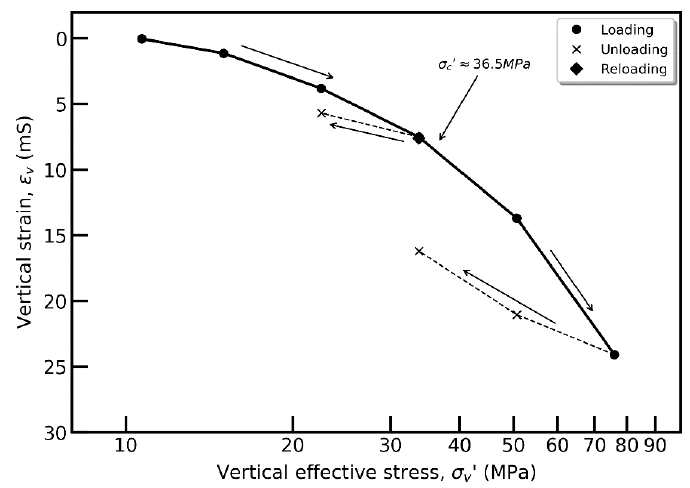
Figure 13. The vertical strain plotted against the logarithm of vertical effective stress for the oedometer incremental loading test on a vertical Draupne sample. Markers indicate the last point of a load step before the next loading, reloading or unloading step.